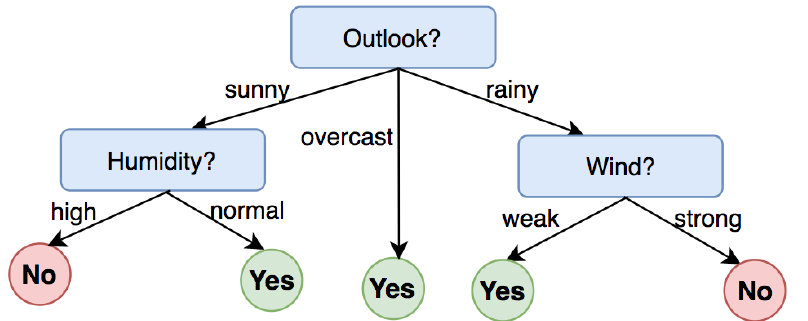
Figure 5. Example of decision